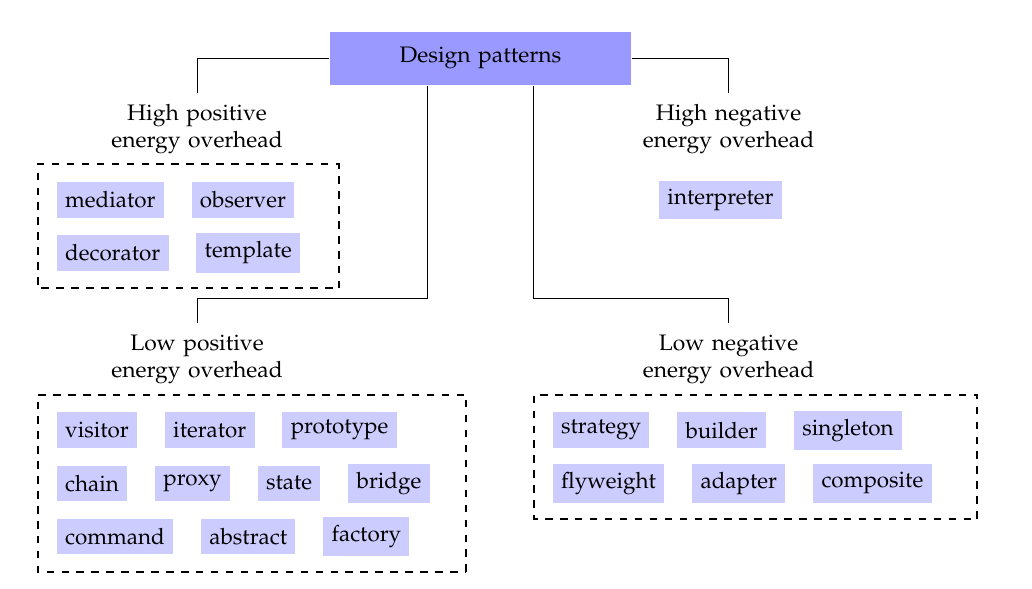
Figure 2. Object oriented design patterns taxonomy for the computer